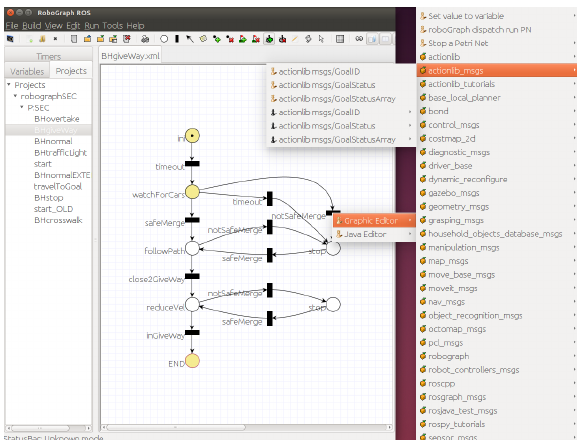
Figure 2. RG GUI editing the BHgiveWay Petri net